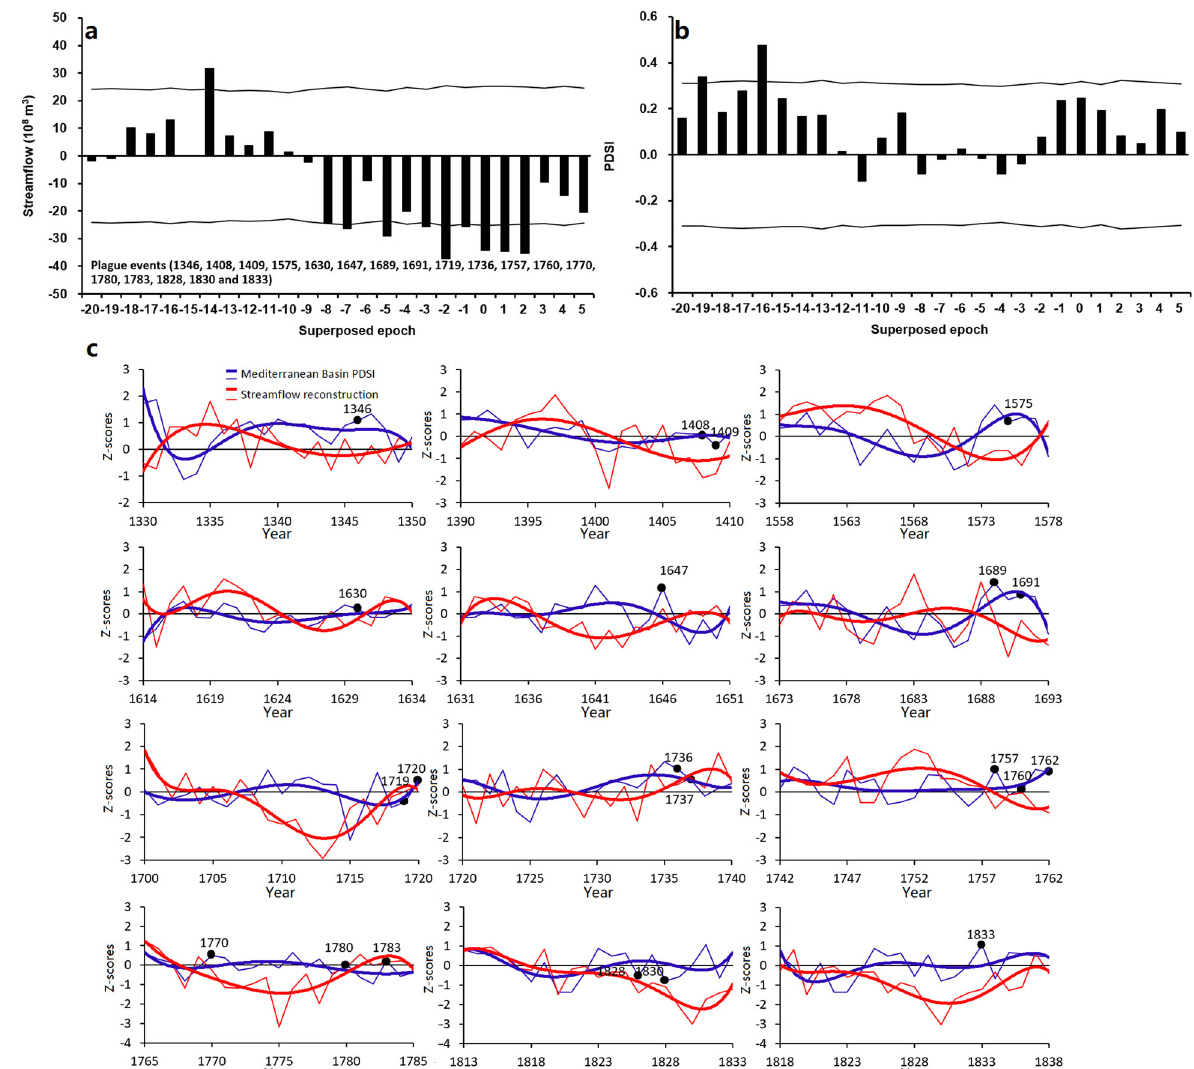
Fig. 4 The response of Central Asian stream fl ow to the plague outbreaks. Results of the superposed epoch analysis (SEA) testing the response of Central Asian stream fl ow ( a ) and PDSI of the Mediterranean Basin ( b ) to the outbreak of the plague events (Supplementary Table 2). The solid lines indicate the 95% signi fi cance level. c Comparison between the reconstructed August – July total stream fl ow (red curve) and PDSI reconstruction of the Mediterranean Basin (blue curve) 16 . Thick curves are trend lines of the reconstructions along with the circulars representing the outbreak years of the plague in the Mediterranean Basin and